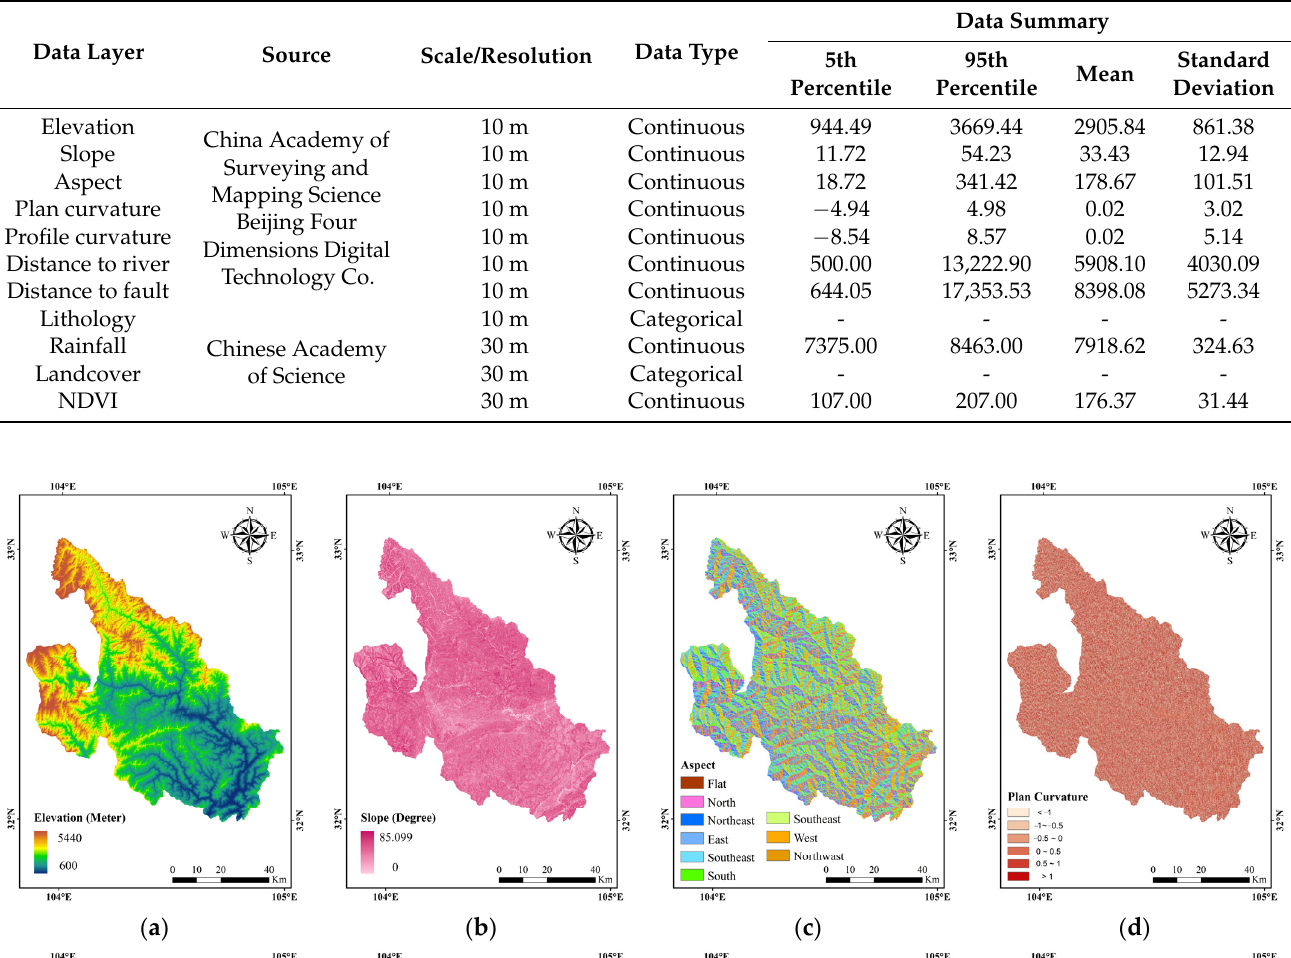
Table 1. Summary of data.